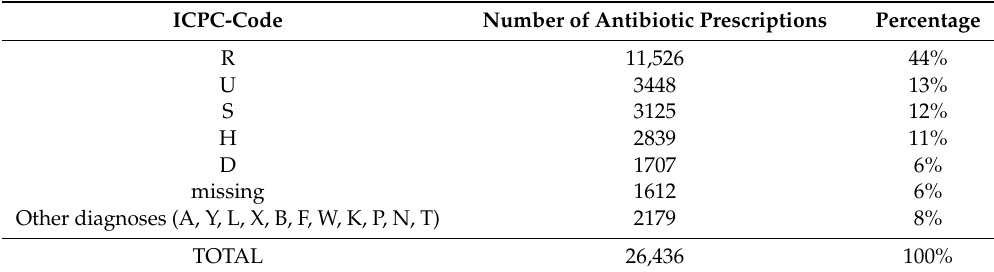
Table 2. Number of antibiotic prescriptions in a two-year time frame linked to diagnostic group (total patient contacts (excluding home visits) = 111,600). ICPC-Code Number of Antibiotic Prescriptions